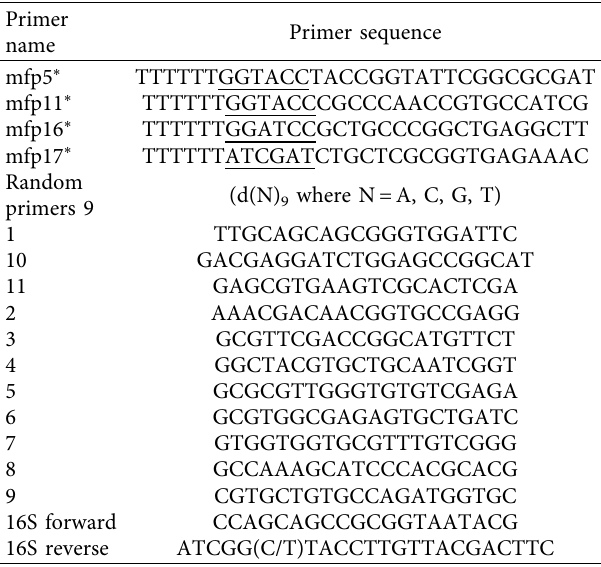
Figure 1: Schematic representation of the mfp EA operon. The arrows indicate the regions to be amplified with different primers. Table 2: Primers used in this study.